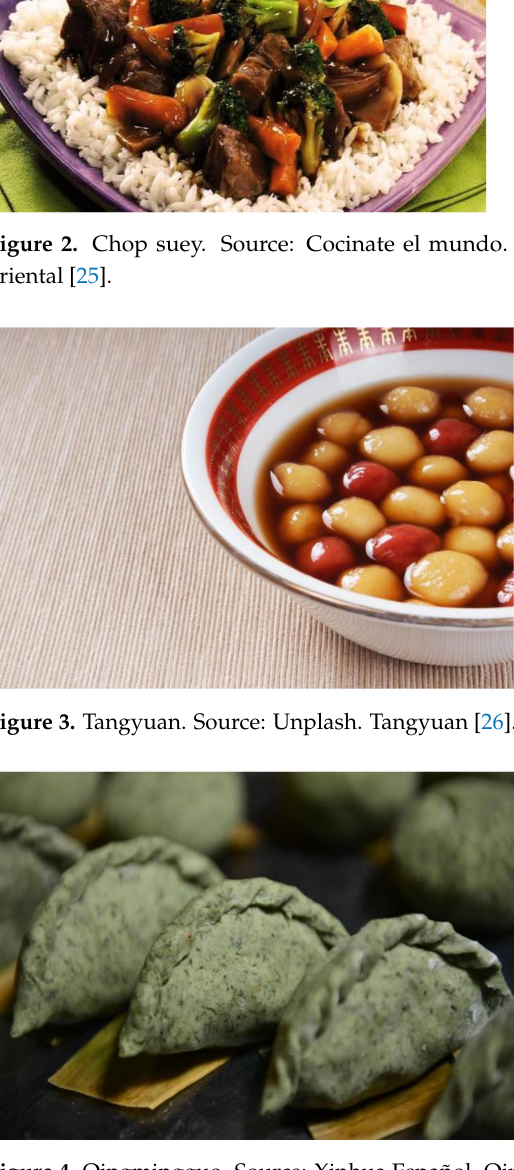
Figure 4. Qingmingguo. Source: Xinhua Español. Qingmingguo, Comida de primavera